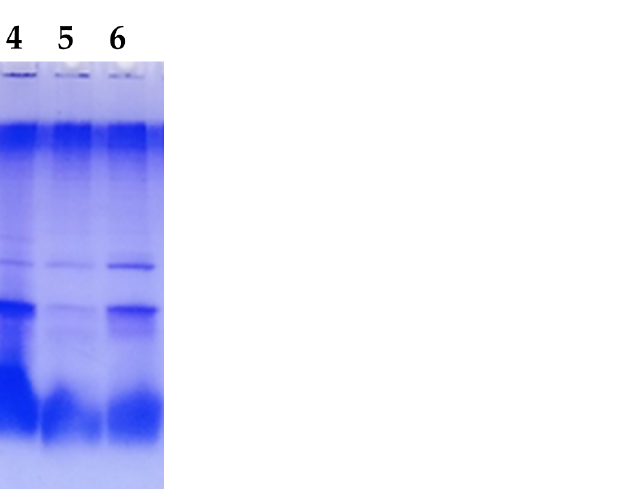
Figure 4. Polyacrylamide gel electrophoresis of Mexican Hirsutella citriformis OP-Hir-10 strain gum. Lane 1 = molecular size marker; lane 2 = supernatant; lane 3 = gum dissolved in solvent (sample was off the gel lane); lane 4 = mycelium; lane 5 = mycelium + gummous material dissolved in solvent and sonicated (five pulses/40 W/30 s); lane 6 = sonicated gummous material.